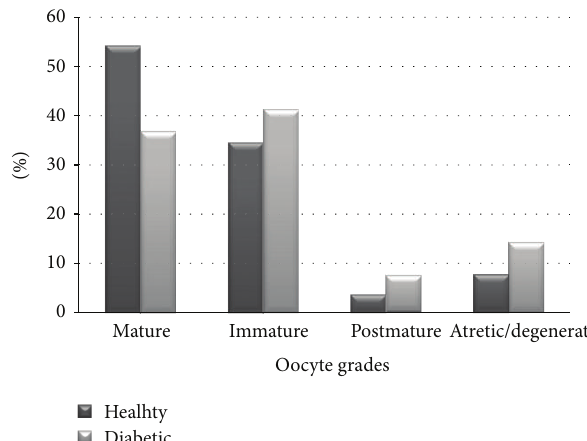
Figure 2: Comparison of oocyte qualities between healthy and diabetic female